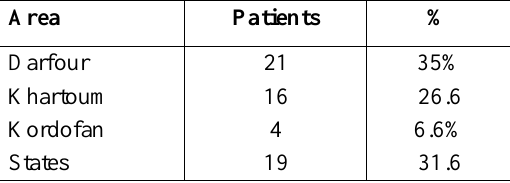
Table 4. Frequency of cutaneous leishmaniasis patients according to the